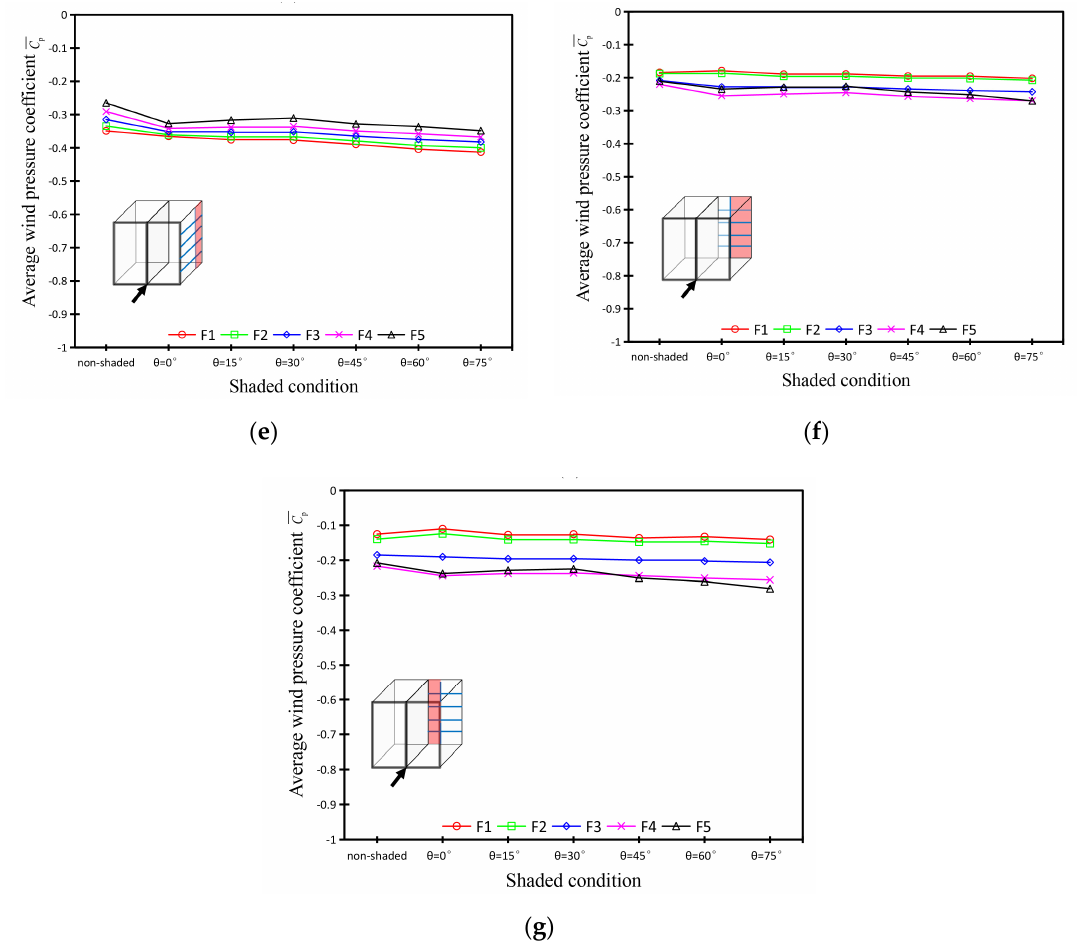
Figure 15. Average wind pressure coefficient C p on outside surfaces of rooms under different shaded conditions for ( a ) R1; ( b ) R2; ( c ) R3; ( d ) R4; ( e ) R5; ( f ) R6; ( g ) R7.